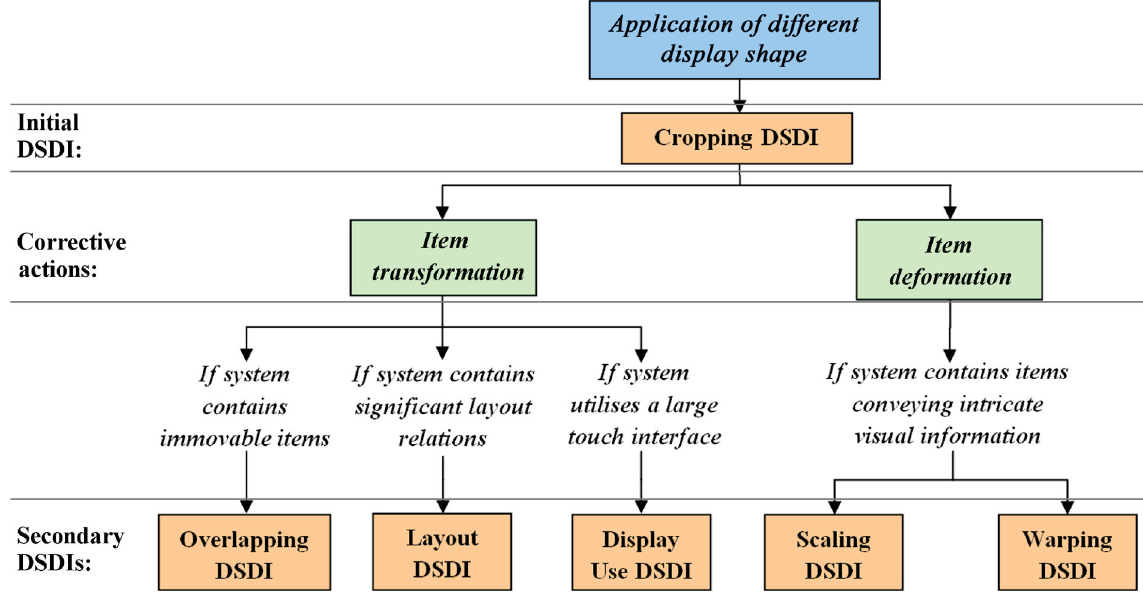
Fig. 1 A flowchart indicating causality of display shape dependence issues